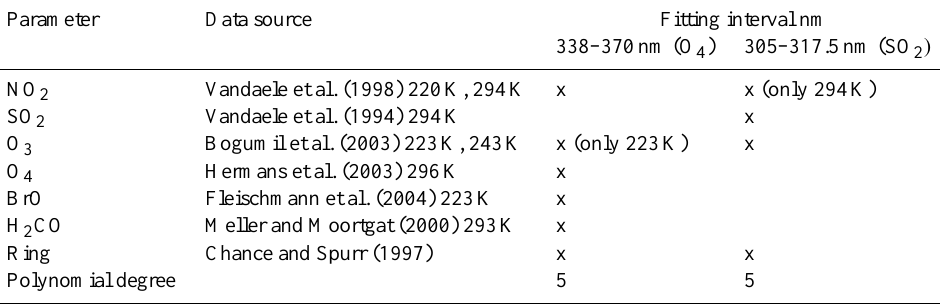
Table 1. Settings used for the SO 2 and O 4 DOAS